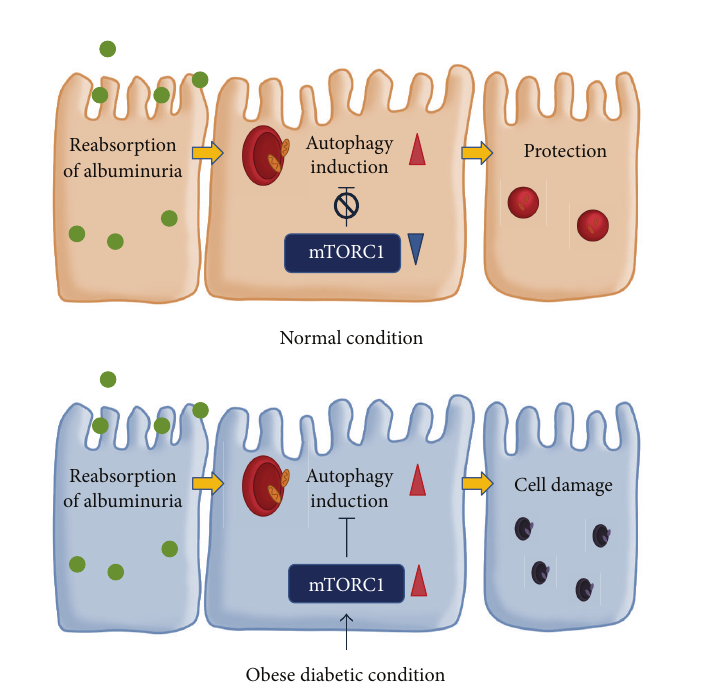
Figure 4: Autophagy in proximal tubular cells under diabetic conditions. Proximal tubular cells show low rates of autophagy under basal conditions. Proteinuria renoprotectively elicits autophagy in proximal tubular cells (upper panel). Obesity suppresses proteinuria-induced autophagy via hyperactivation of mTORC1 in proximal tubular cells, leading to obesity-mediated exacerbation of proteinuria-induced tubulointerstitial damage (lower